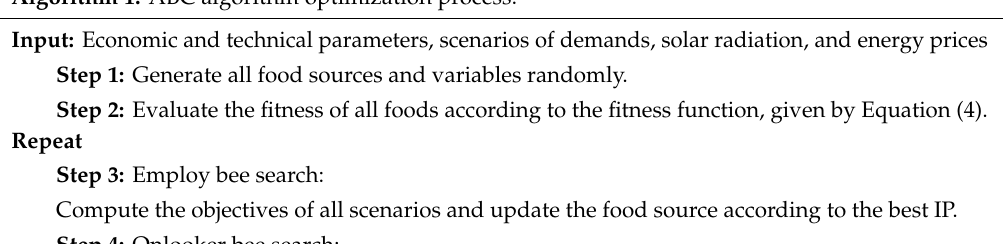
Figure 3. Stochastic programming process by the artificial bee colony (ABC) algorithm. Algorithm 1: ABC algorithm optimization process